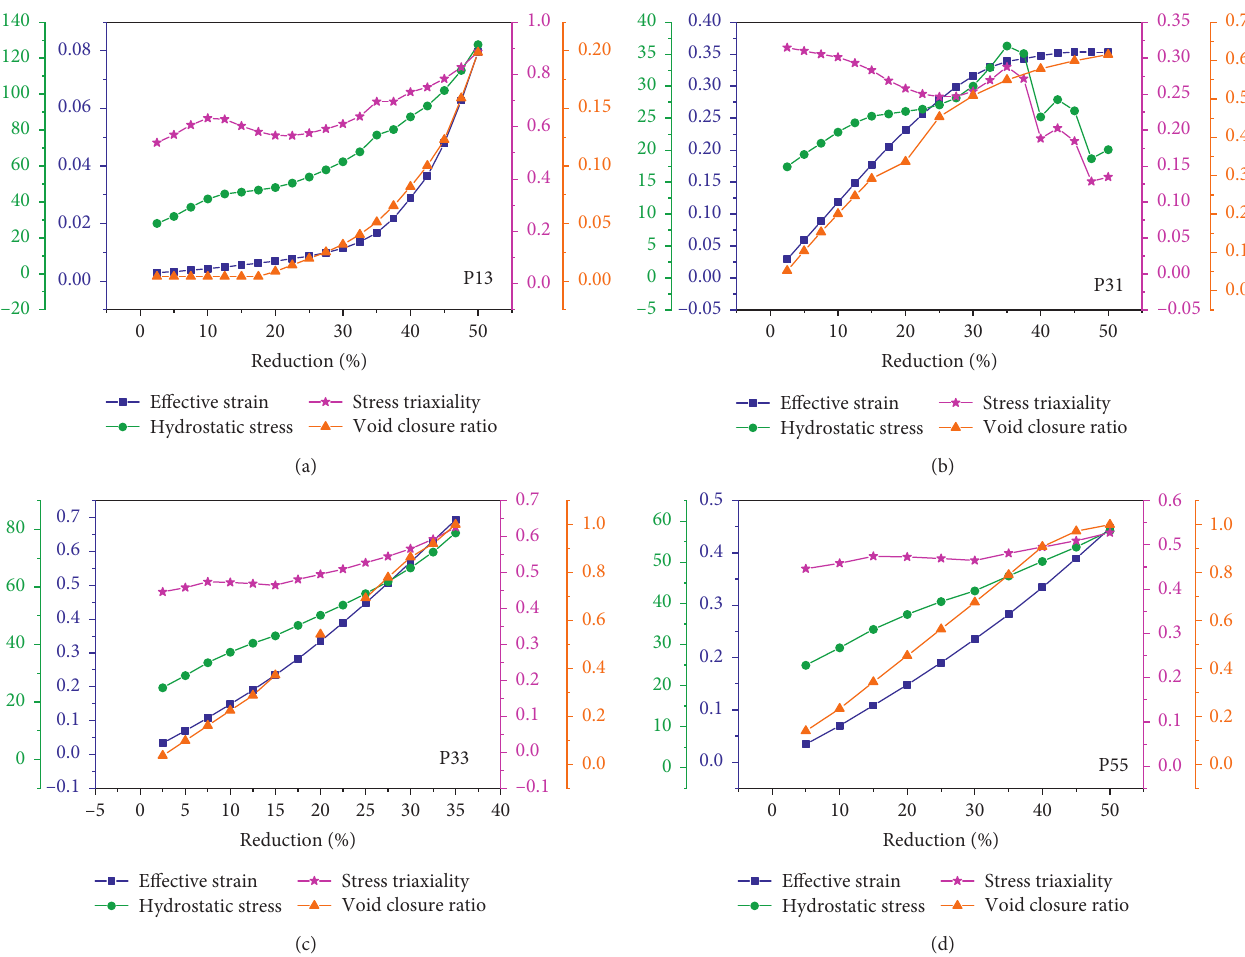
Figure 3: Relationship between void closure ratio and effective strain, absolute value of hydrostatic stress, and stress triaxiality. (a) P13. (b) P31. (c) P33. (d) P55.